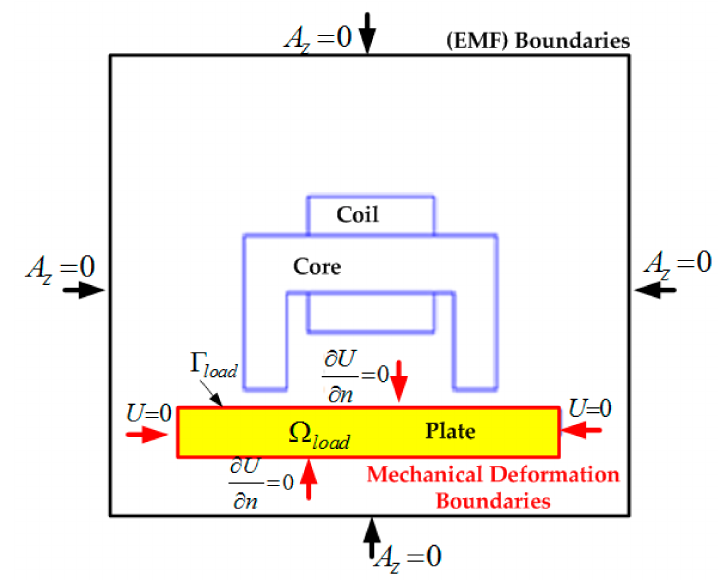
Figure 4. Electromagnetic and mechanical deformation boundary conditions.